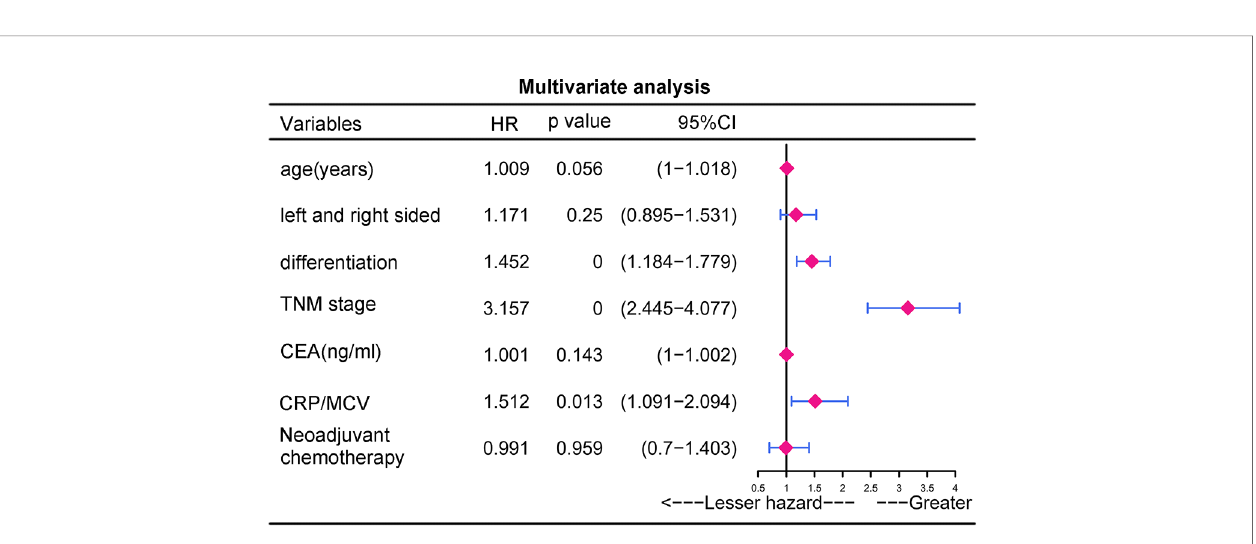
FIGURE 6 | Multivariate analysis of prognostic risk factors for lymph node positive CRC. Multivariate analysis is a multivariate regression analysis of the variables found by univariate